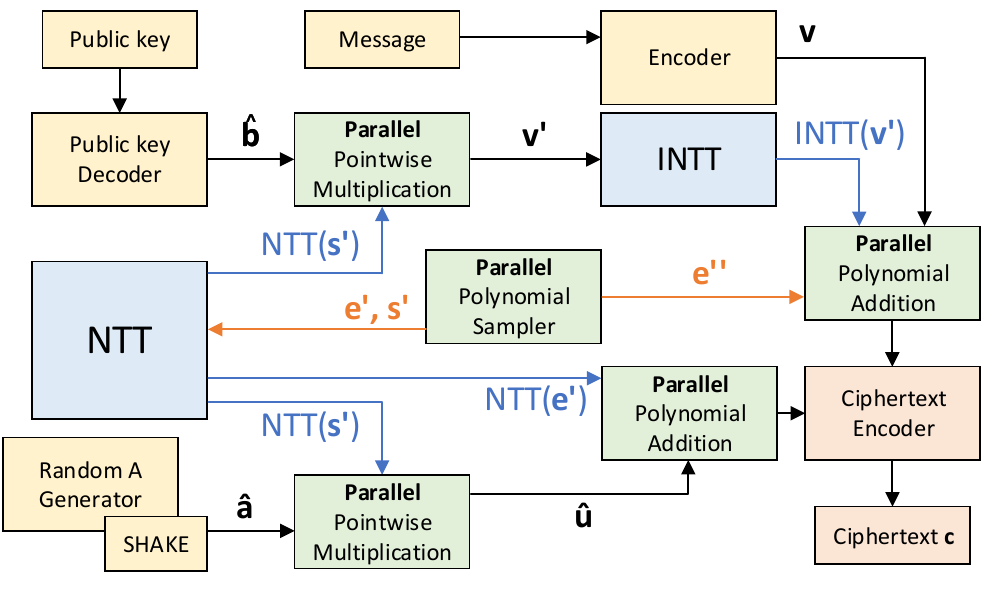
Figure 6. NewHope encryption with partial parallelism.